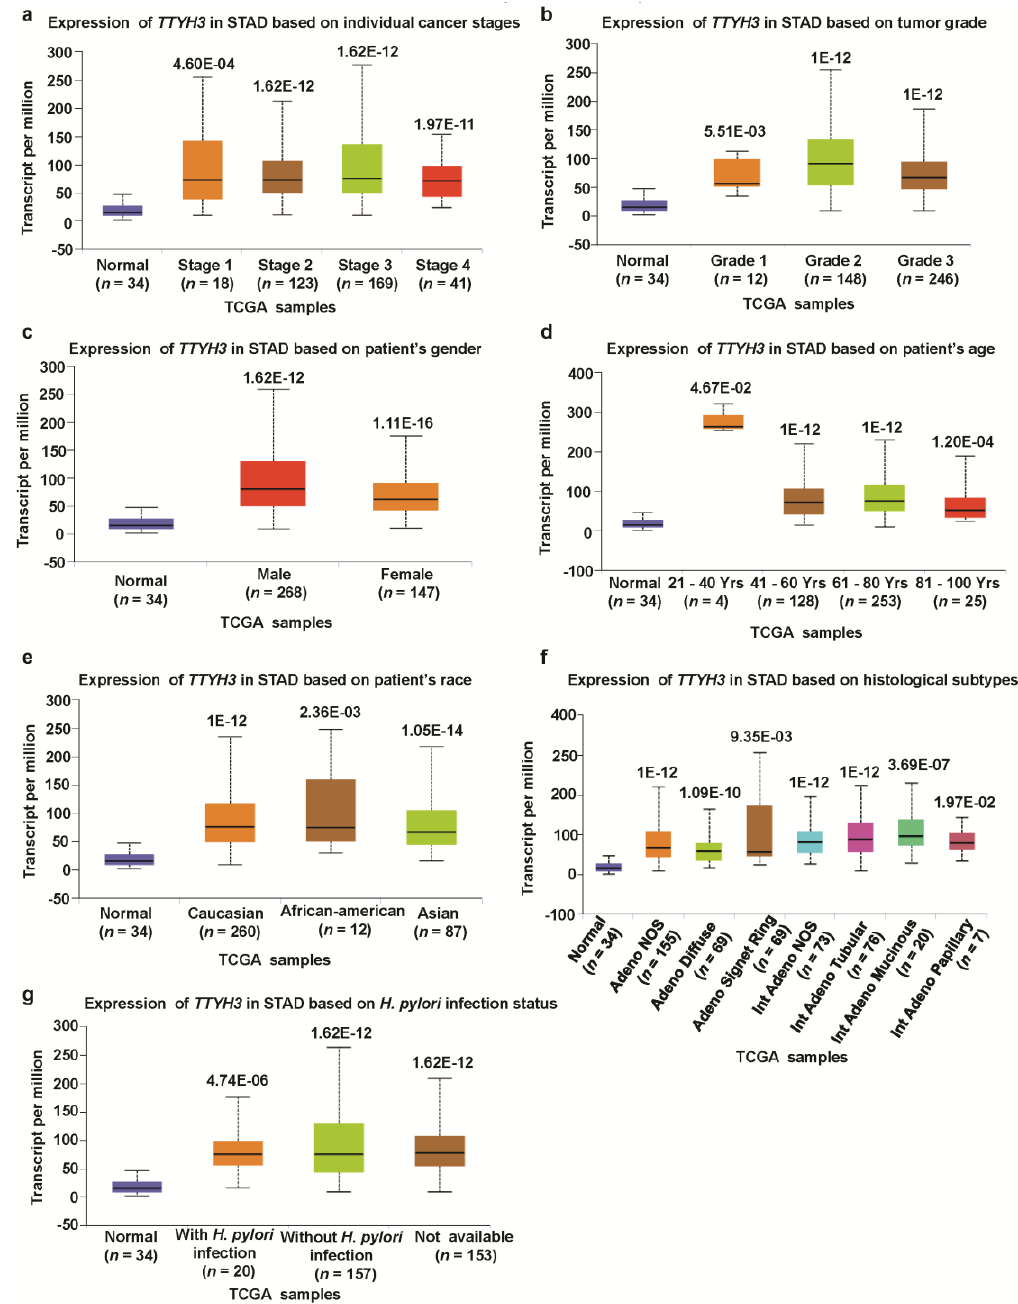
Figure 3. Association between TTYH3 expression and clinical characteristics of GC/SC patients: The TTYH3 mRNA expression level was expressed by box plots using UALCAN web (http://ualcan.path.uab.edu/index.html) for the patient characteristics of ( a ) individual cancer stages, ( b ) tumor grade, ( c ) patient gender, ( d ) patient age, ( e ) patient race, ( f ) histological subtypes, and ( g ) Helicobacter pylori infection. Abbreviation: STAD, Stomach Adenocarcinoma.